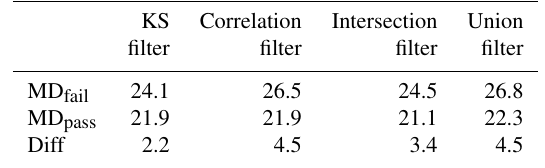
Table 2. Mean distance (MD) of four tests averaged over 549 days of warm season. Diff is the difference between the first and second row.